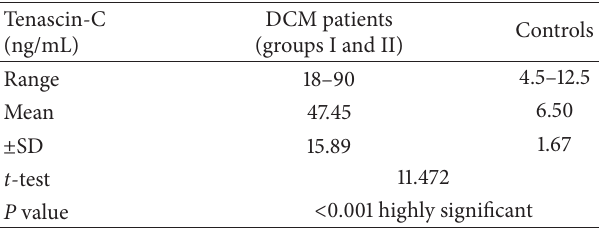
Table 1: A highly significant statistical difference between patients and controls as regard serum tenascin-C level.